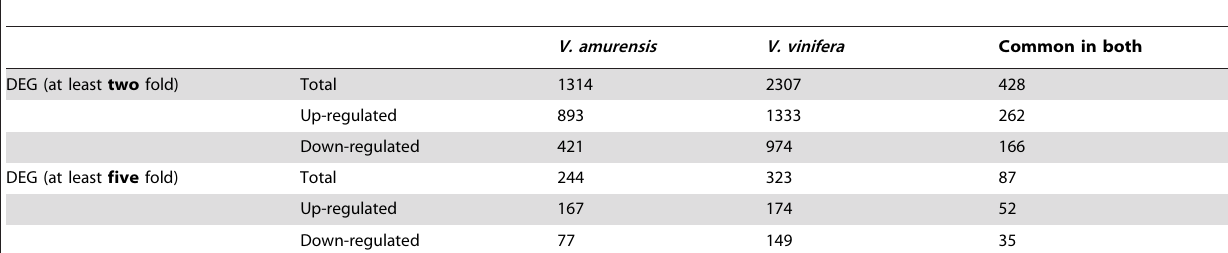
Table 3. Differential expressed genes (DEG) in V. amurensis and V. vinifera cv. Muscat of Hamburg during cold treatment.